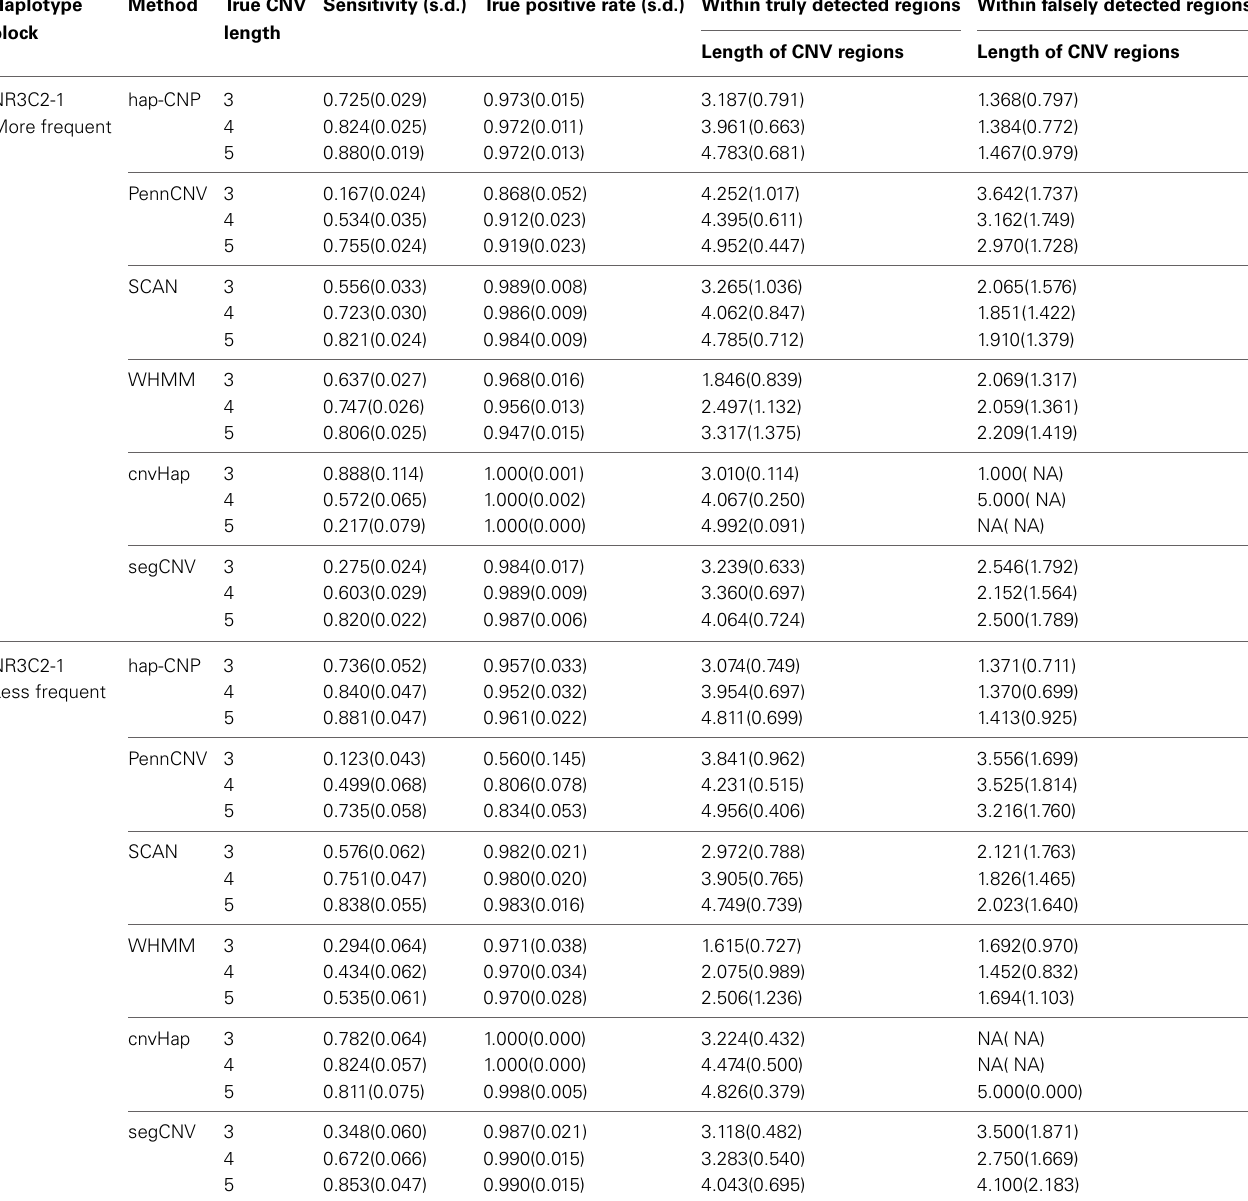
Table 3 | Summary of CNV region and genotype calls from all methods.